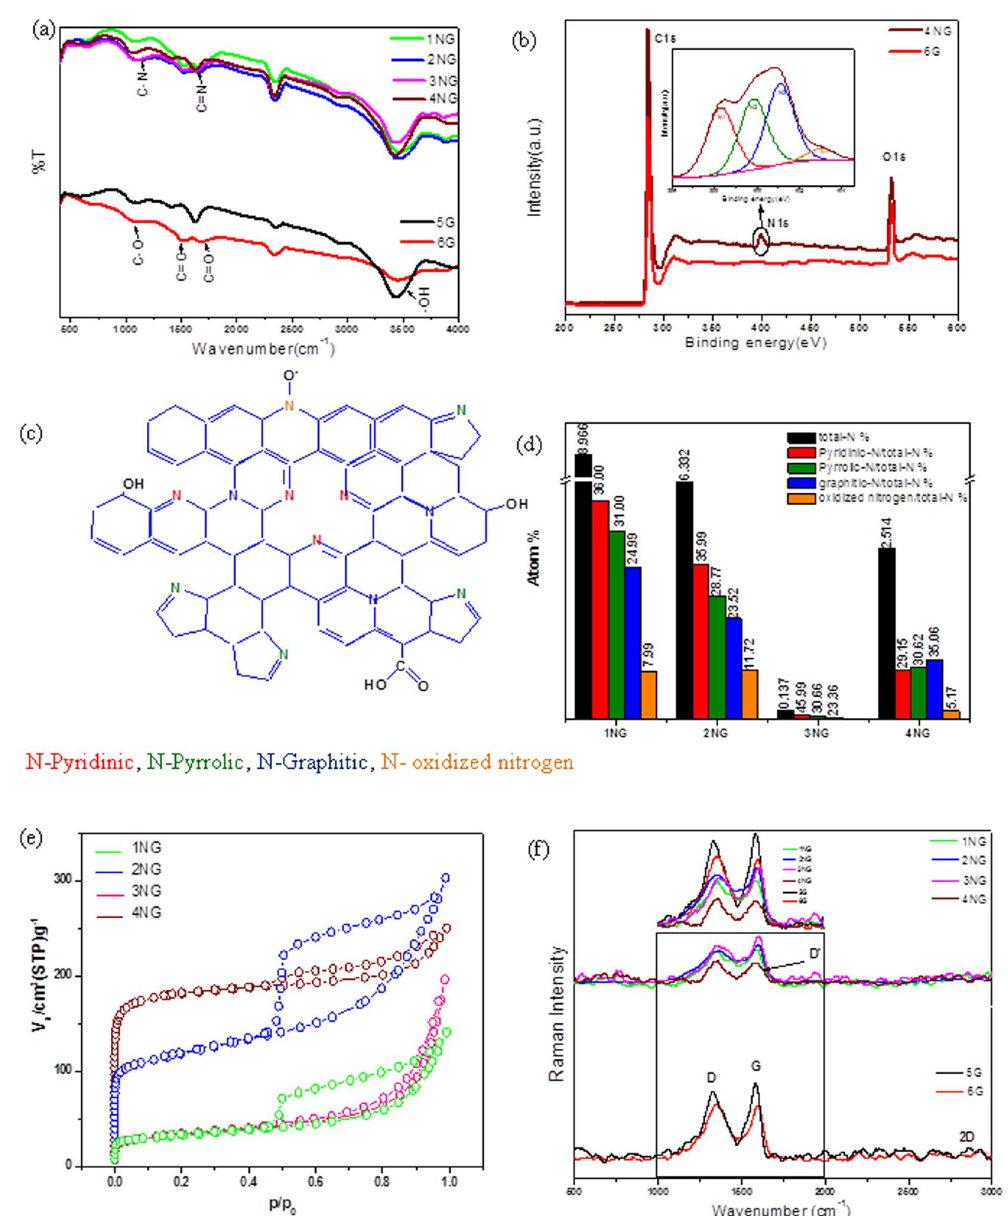
Figure 1. Materials characterization. ( a ) FTIR, ( b ) XPS spectra survey (inset) high resolution N1s XPS spectra of 4NG sample, ( c ) Schematic suggested structure of NG based on the result of XPS analysis, ( d ) atomic % of nitrogen in every NG sample and their components, ( e ) Nitrogen adsorption-desorption isotherms of nitrogen doped graphene samples and and ( f ) Raman